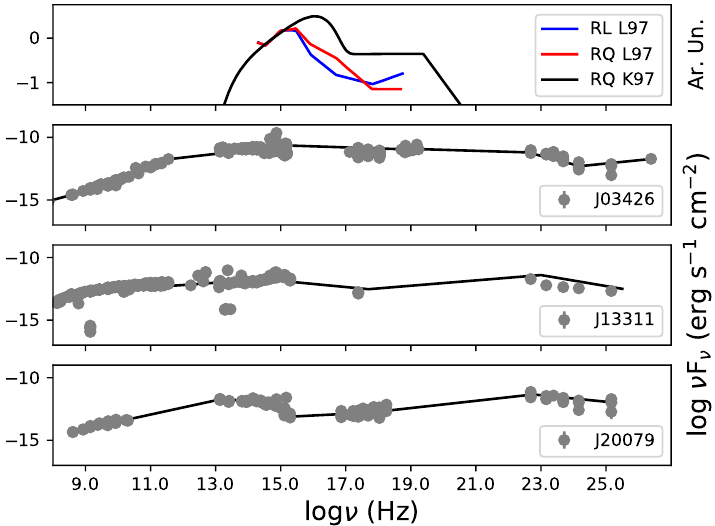
Figure 9. The SEDs used for photoionization computations. From top to bottom: (1) SED of RL and RQ sources from Laor et al. [88], represented by the blue and red solid line, respectively, and from Korista et al. [89] for RQ shown with black solid line. The y-axis for the upper panel is shown with arbitrary units (Ar. Un.) for the specific flux; (2) SED of J03426. The observed data points are shown in grey, while the SED used in the models is represented by the black solid line, (3) as in (2) for J13311; (4) as in (2) for